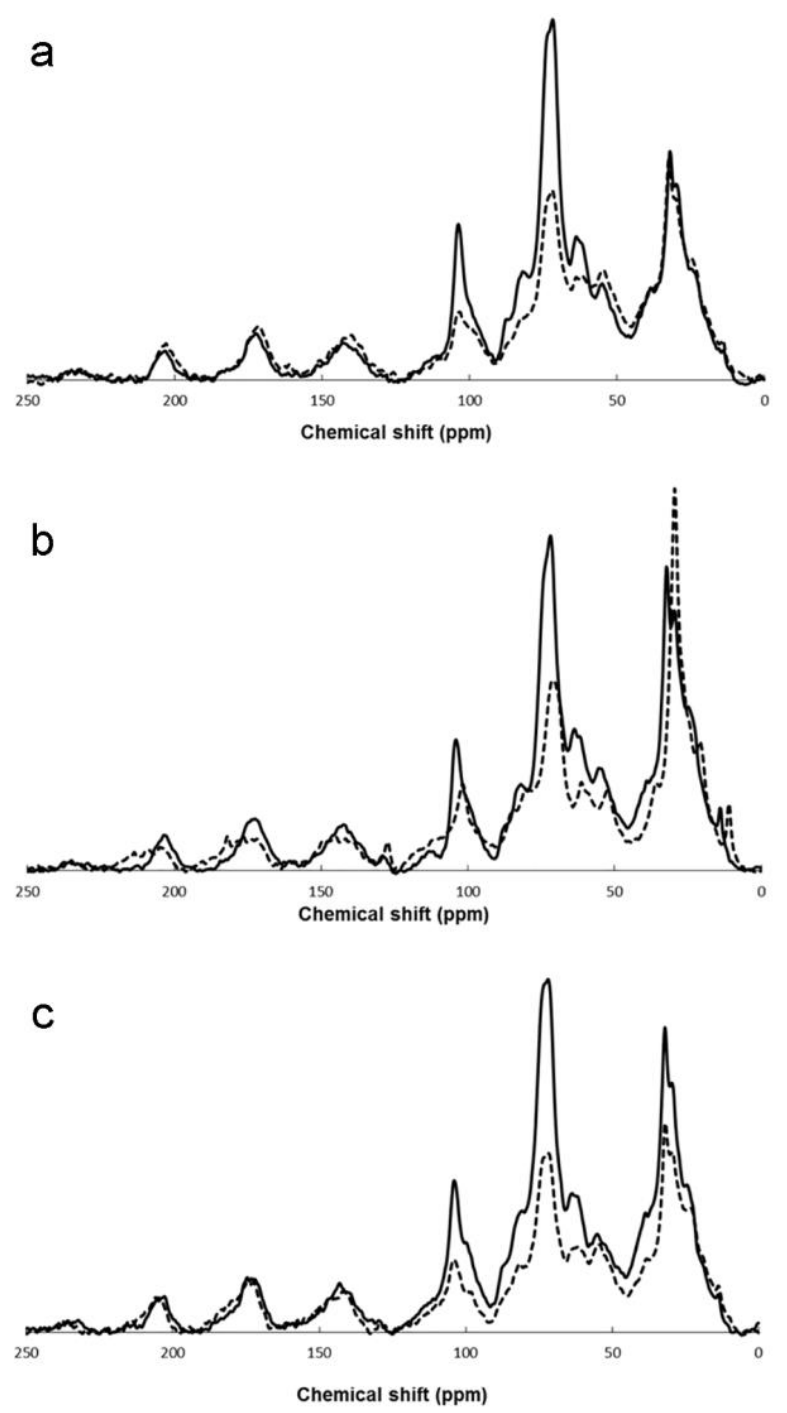
Figure 2. 13 C CP-MAS NMR spectra of composts (dashed line) and corresponding feedstocks (solid line). Feedstock compositions are: ( a ) exhausted grape marc and cattle manure 76:24 ( w : w ); ( b ) grape marc and cattle manure 72:28 ( w : w ); ( c ) exhausted grape marc and poultry manure 67:33 ( w : w ). Reproduced with permission from Ref. [69].